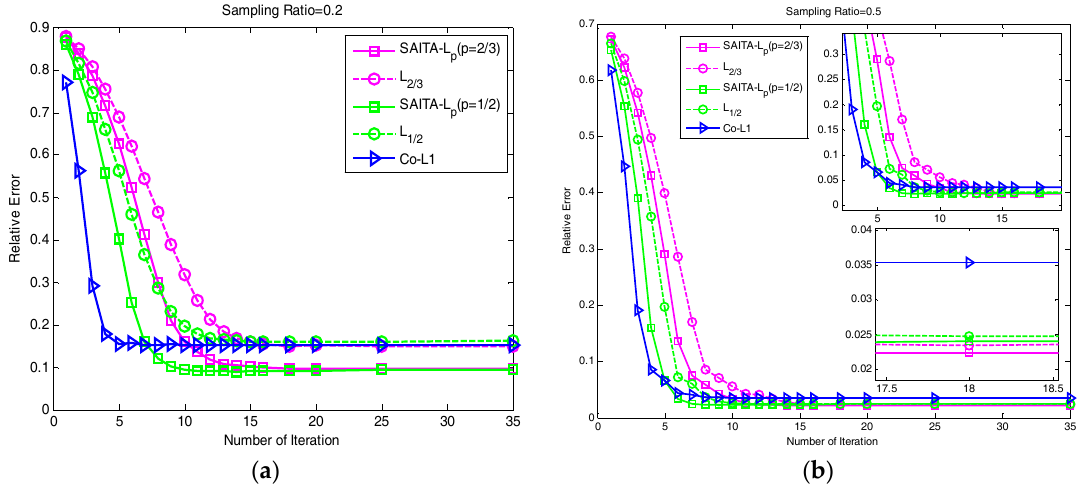
Figure 7. ( a ) The relative error for the lower sampling ratio M / N = 0.2 in the cameraman image. ( b ) The relative error for the higher sampling ratio of M / N = 0.5 in the cameraman image. The relative errors verse the iteration number of the proposed SAITA- L p algorithm and the L p